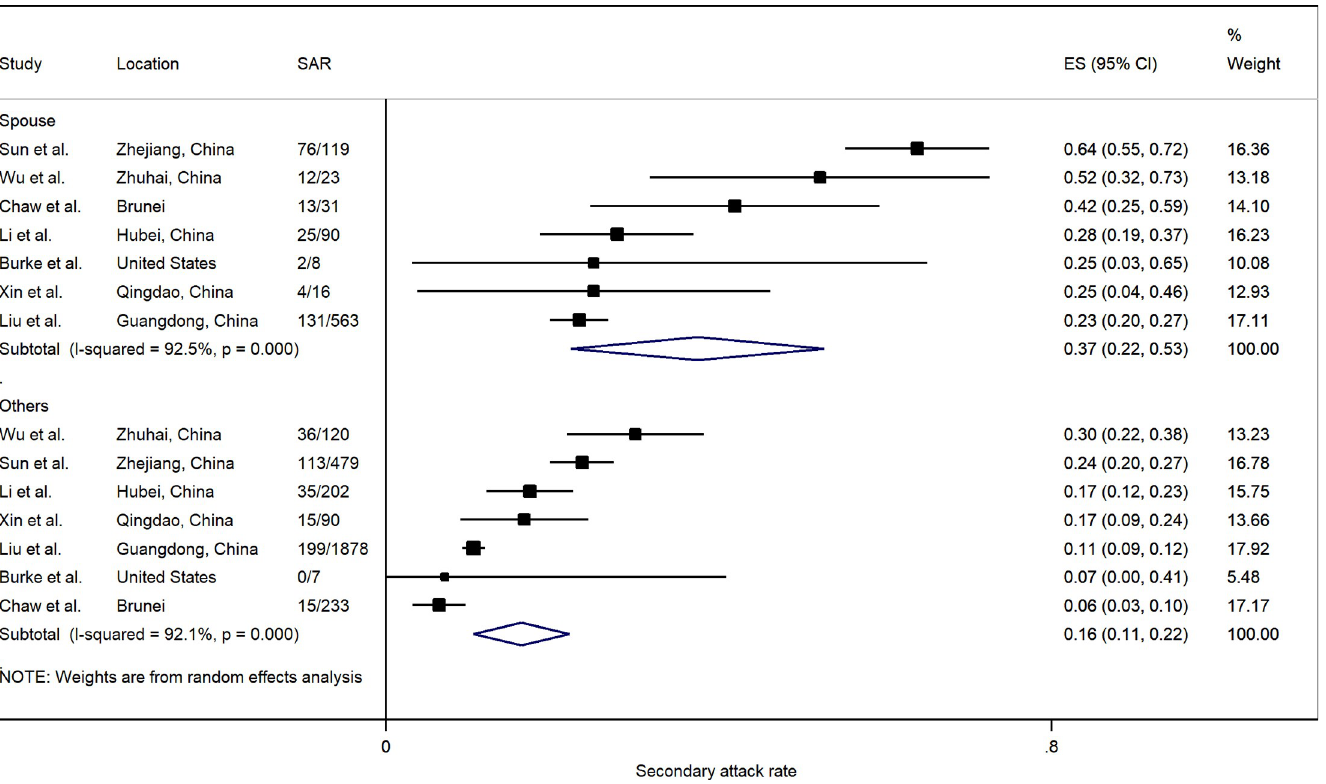
Fig 8. Forest plot of household secondary attack rates (SAR) by relationship to index case. ES is the estimated SAR, with 95% confidence intervals (CI). I-squared is the percentage of between-study heterogeneity that is attributable to variability in the true effect, rather than sampling variation.